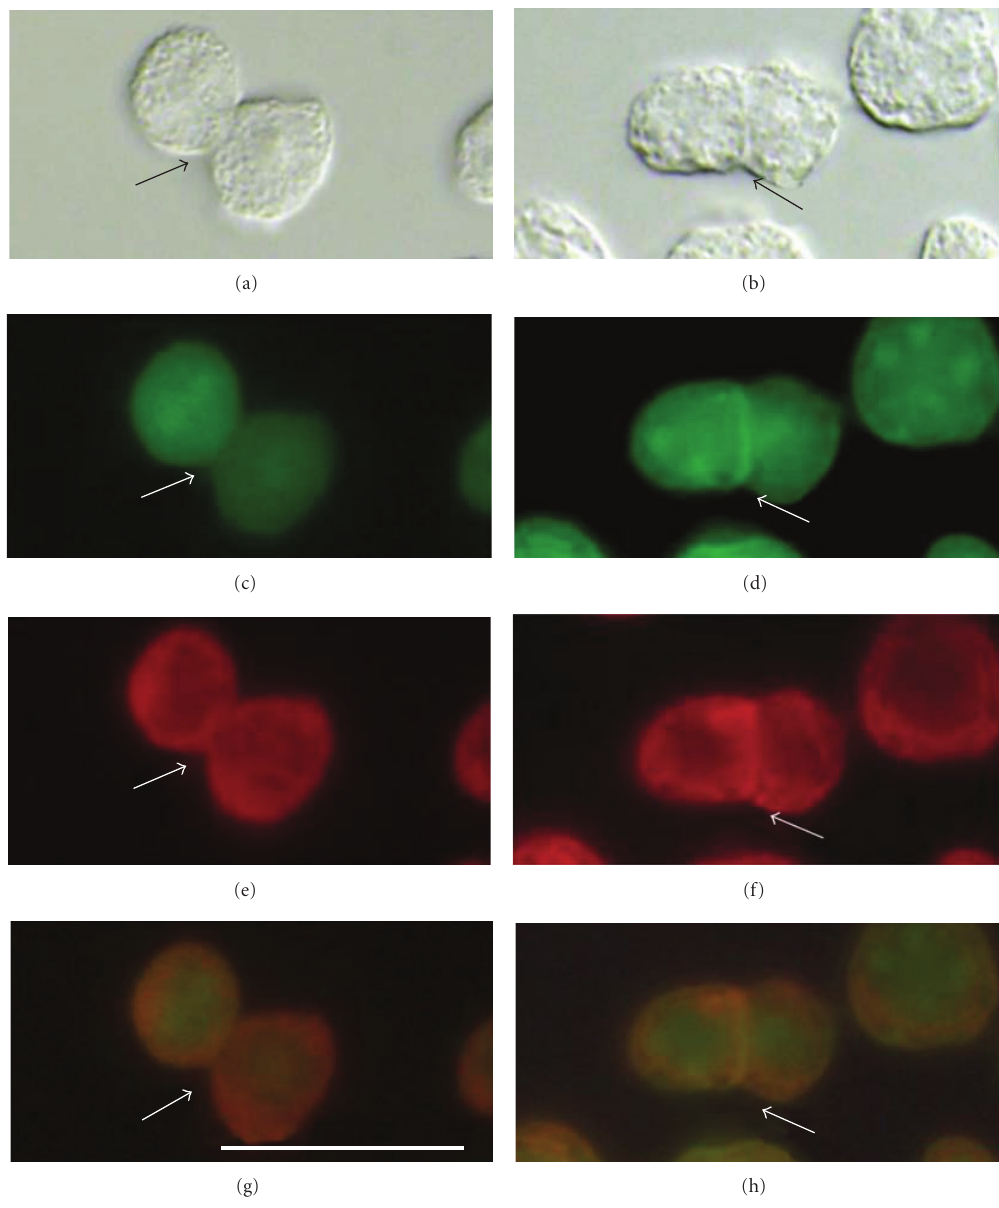
Figure 4: Immunocytochemical detection of the PKC-mediated ZYG1 phosphorylation. Starved GFP CONT and GFP/ZYG1 OE cells were developed for 2 h, fixed with methanol, and stained by the Phospho-(Ser) PKC Substrate antibody. This was followed by the rhodamine- conjugated anti-rabbit secondary antibody to detect the proteins phosphorylated by cPKC, as described in Section 2. Photographs were taken under DIC (a and b) and fluorescence microscope (GFP, (c) and (d); Rhodamine, (e) and (f); GFP and Rhodamine merged, (g) and (h)). Photographs represent the same fields of GFP CONT cells (a, c, e, g) and of GFP/ZYG1 OE cells (b, d, f, h). GFP protein in GFP CONT cells and GFP/ZYG1 fusion protein in GFP/ZYG1 OE cells are shown as the green color of GFP (c and d). In GFP/ZYG1 OE cells, GFP/ZYG1 fusion protein is localized at the region of cell-cell contacts (d; arrow). On the other hand, the localization of GFP protein at the region of cell-cell contacts is not observed in GFP CONT cells (c; arrow). This indicates that its localization is due to the presence of ZYG1, but not to GFP itself. The protein phosphorylated by PKC is shown as the red color of Rhodamine in both cells ((e) and (f)). The protein phosphorylated by PKC is also localized at the region of cell-cell contacts in GFP/ZYG1 OE cells (f; arrow). This localization shown by Rhodamine is not observed in GFP CONT cells (e; arrow). Since the merged color of GFP and Rhodamine shows yellow in GFP/ZYG1 OE cells (h; arrow), it is evident that ZYG1 protein is phosphorylated by cPKC at the regions of cell-cell contacts. Bar: 25 μ